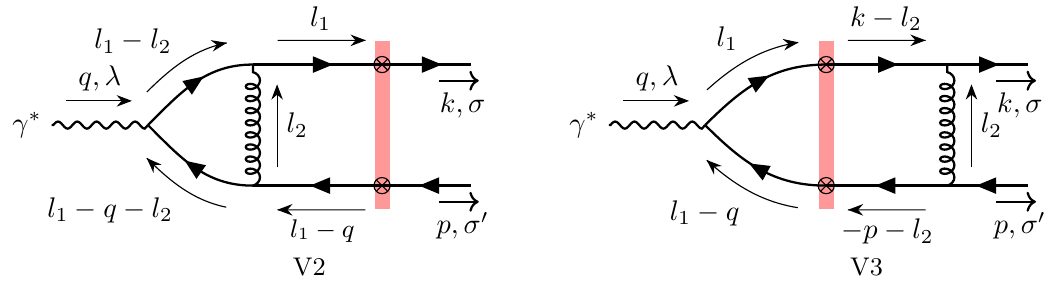
Figure 10 . Free vertex correction before the shock wave (left) and after